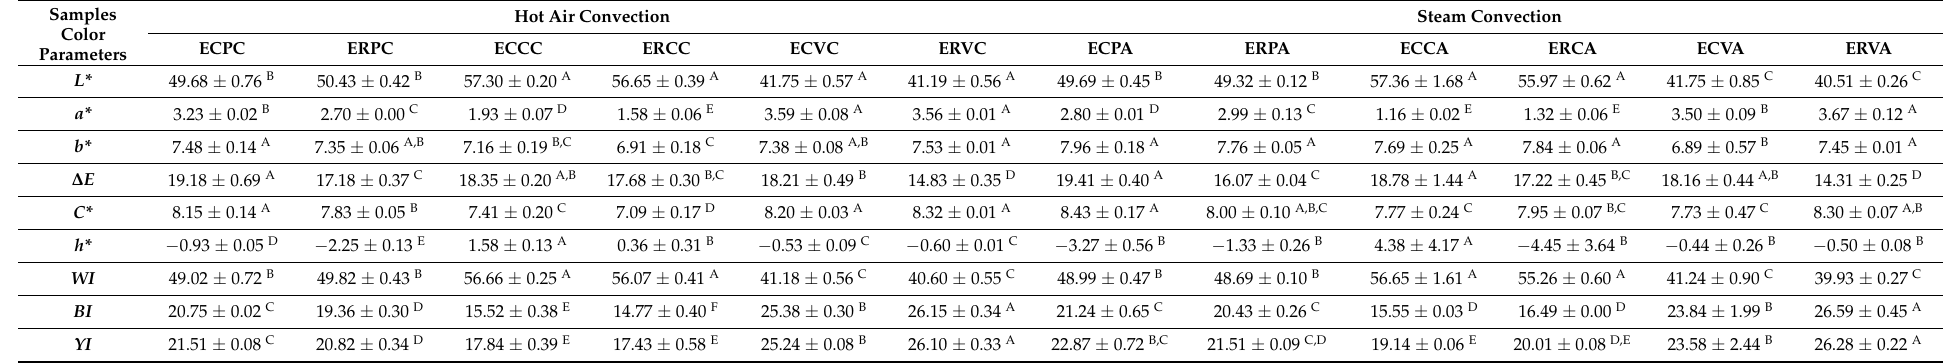
Table 3. Effects of heat treatment on the color parameters of one week refrigerated